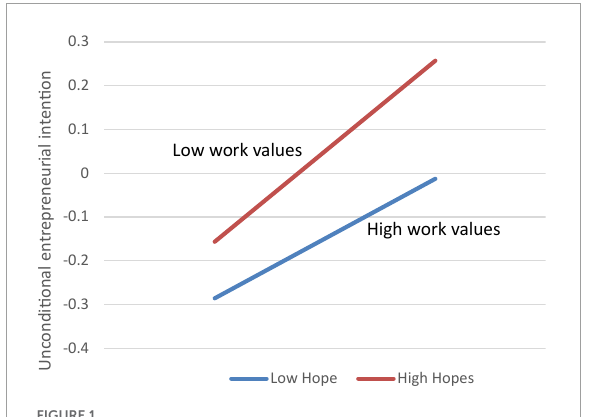
FIGURE1 Simple slope plot of the modulation